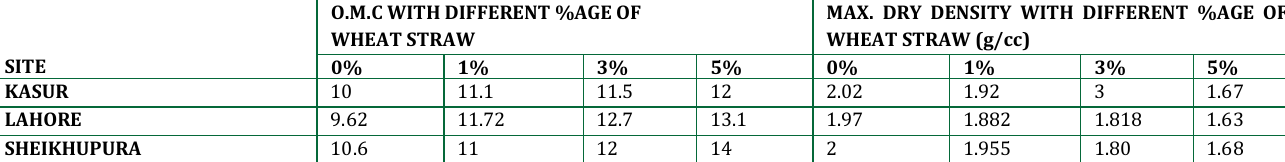
Table 5: Comparison of Compaction Characteristics (Using Modified Procter